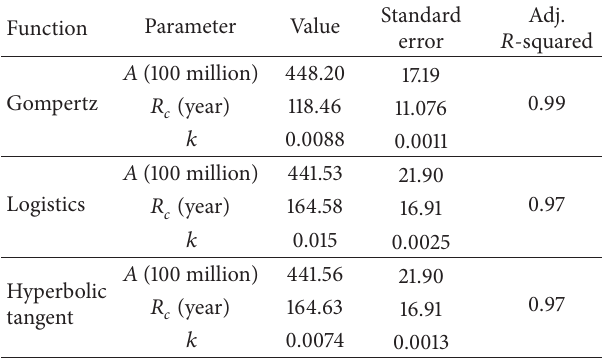
Table 4: Function fitting results in 2005.